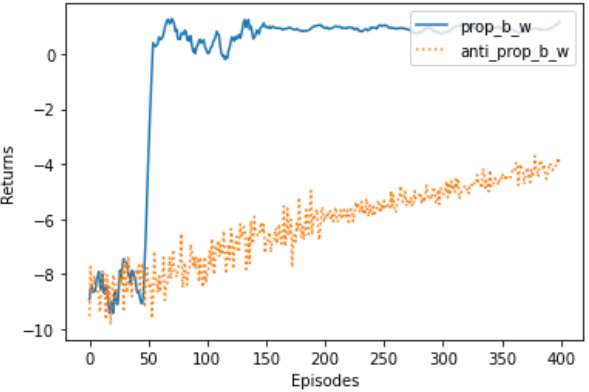
Figure 6. Data efficiency in different training stages.